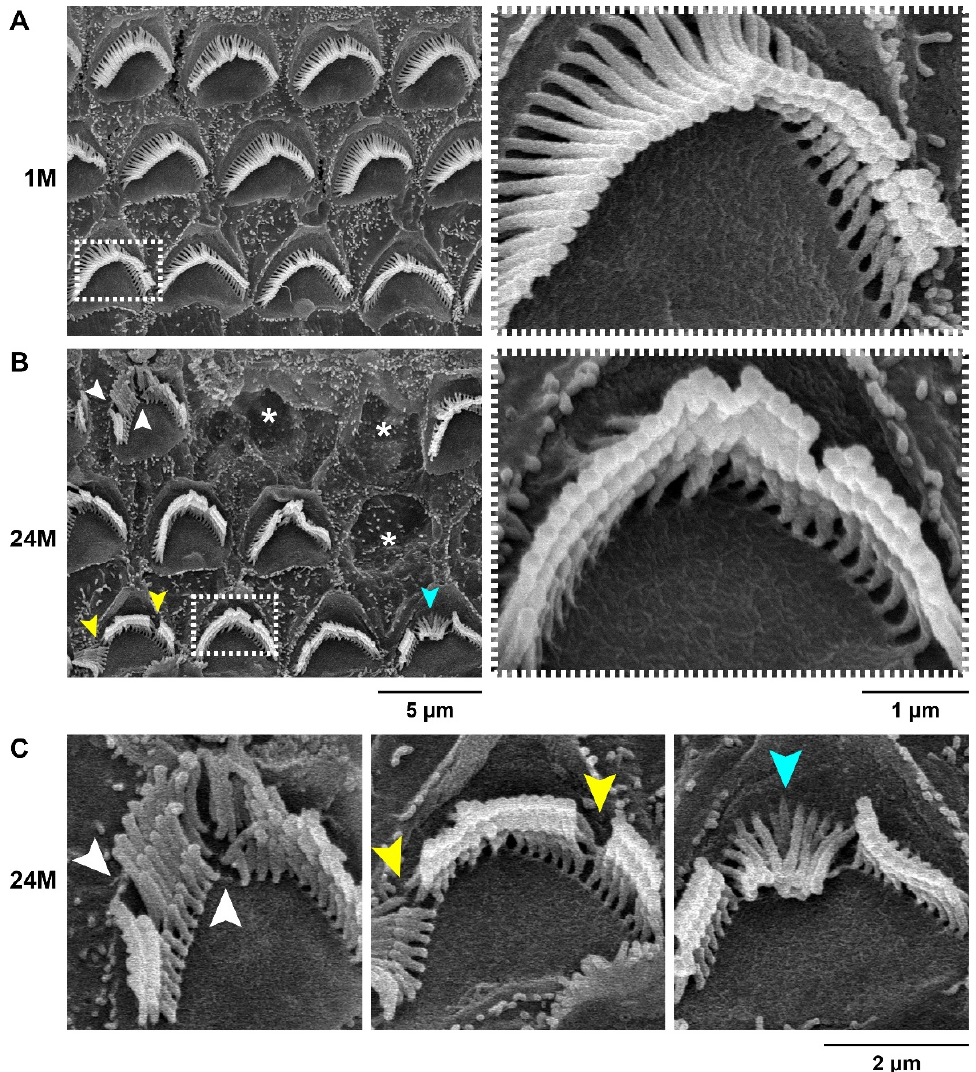
Figure 5. Maintenance and degeneration of the OHC stereocilia bundles in aging MSM strain: ( A , B ) SEM images showing stereocilia in the OHCs within the 16 kHz area of the male MSM mice at 1 and 24 months of age. The right panels are highly magnified images of the white dotted boxes shown in the left panels and show normal staircase patterns of the OHC stereocilia bundles. The asterisks indicate OHCs with absent bundles. ( C ) Abnormal OHC stereocilia bundles in MSM mice at 24 months of age. The images are magnified with OHCs pointed with arrowheads in the left panel in ( B ). The white, yellow, and cyan arrowheads indicate the absence of bundles, separation between the bundles, and inclined bundles, respectively.